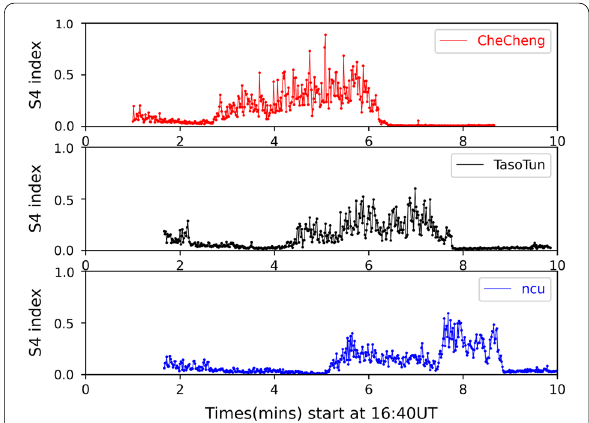
Fig. 5 The S4 index data of 3 stations for a case study of scintillation event. The time started at 16:40UT